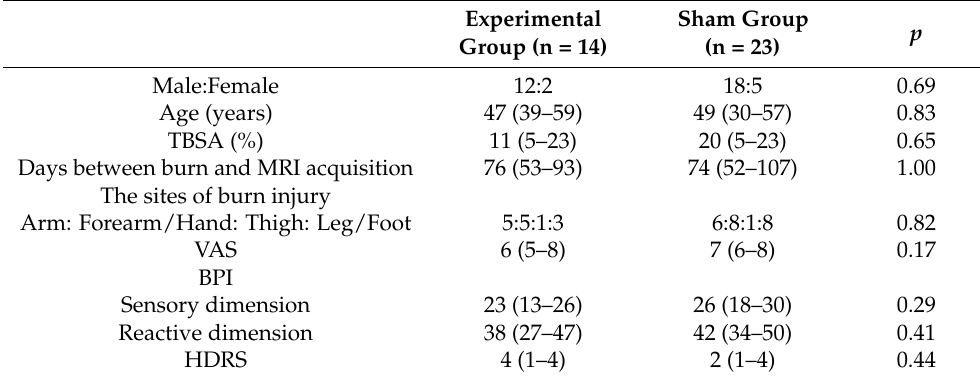
Table 1. Demographic data of